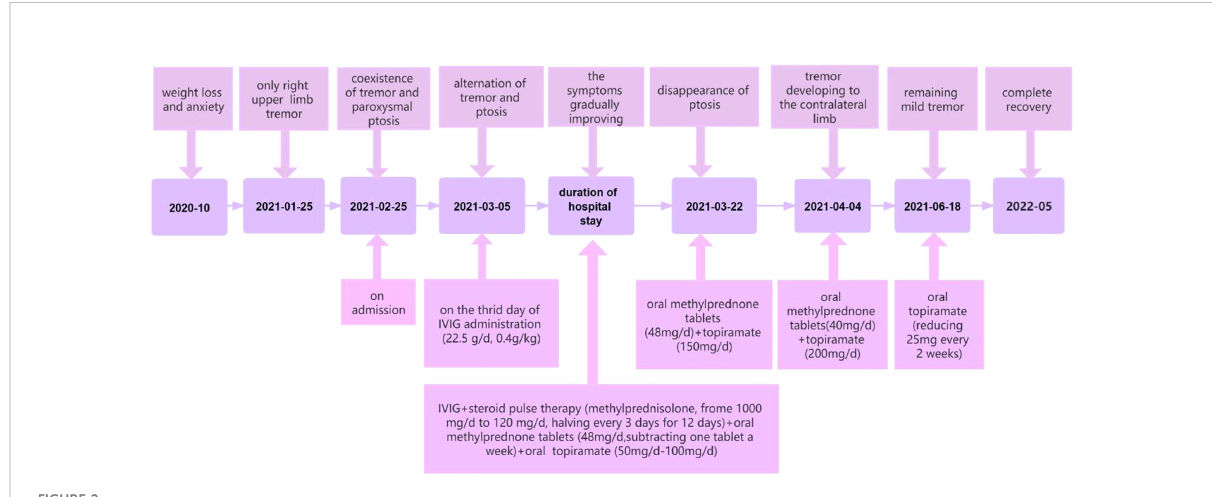
FIGURE 2 Related symptoms and treatment at different time